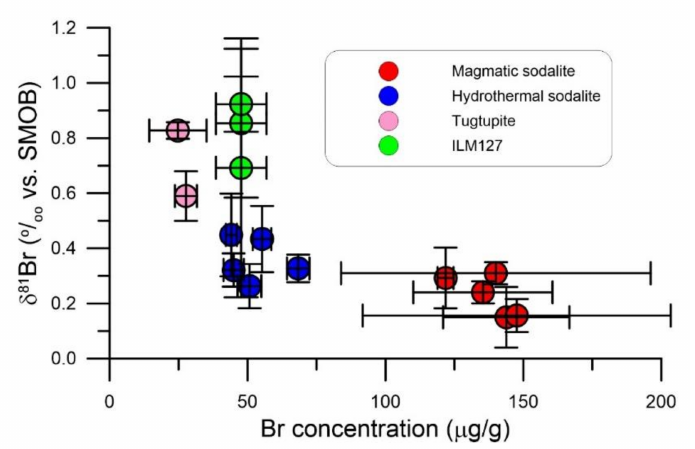
Figure 1. Relationship between the Br content and the δ 81 Br of the sodalite and tugtupite samples measured in this study. Minerals crystallised at later stages have lower Br concentrations and higher δ 81 Br